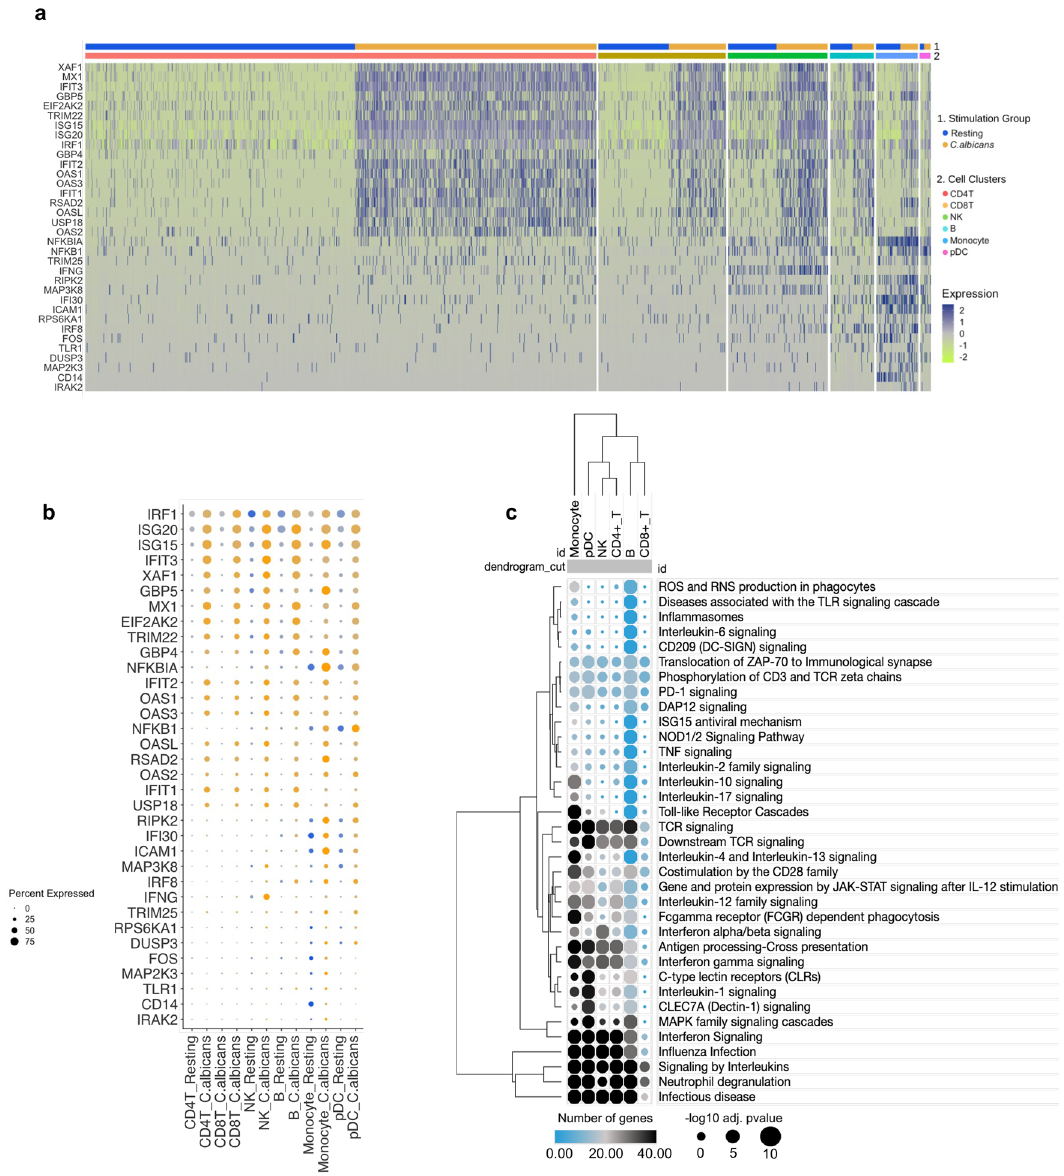
Figure 7. Common TLR- and IFN-associated DEGs and signaling pathways across microarray, bulk, and single-cell RNA-seq datasets. ( a ), Heatmap using expression values from scRNAseq of DEGs also present in microarray and bulk studies; the cell condition and group are indicated by different colors. ( b ), Hierarchical clustering of average expression comparing resting and C. albicans -activated cells. ( c ), Hierarchical clustering showing common pathways selected from Fig. 1d across the cell groups; the size of circles corresponds to adjusted p value transformed into − Log10, and the color intensity indicates the number of genes in each pathway across the cell groups. DEGs, differentially expressed genes; IFN, interferon; TLR, Toll-like receptor; scRNA-seq, single-cell RNA